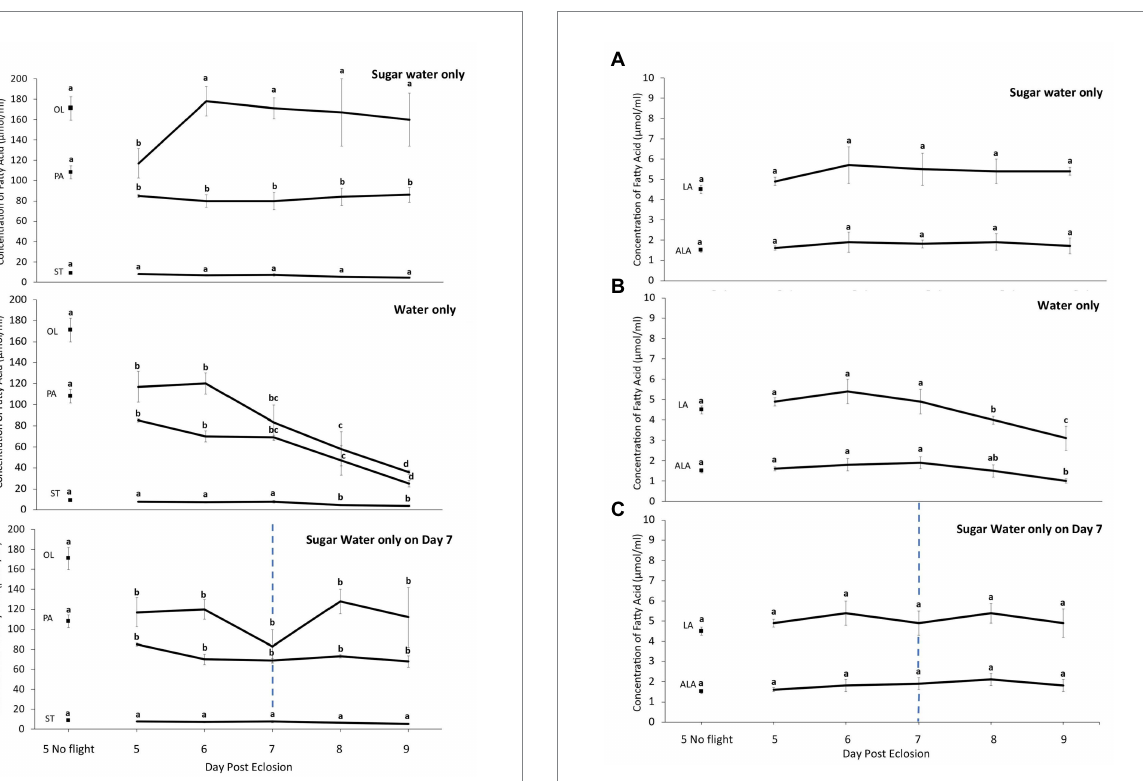
FIGURE 4 Change in the concentration of non-essential [palmitic (PA), oleic (OL) and stearic (ST)] fatty acids in fat body of true armyworm moths reared under fall conditions as a function of the number of 8-h flight periods when fed (A) sugar water ad lib daily, (B) provided water only, or (C) provided water on all days except at the end of Day 7 when they were provided sugar water ad lib during the rest period. The two values for Day 5 represent samples taken from un-flown moths prior to the flight period and from moths after 8 h of flight. In the other days samples were taken at the end of the flight period. Letters indicate statistically significant differences in each category of fatty acid (Tukey’s HSD, p < 0.05). N = 10 per sample group ( N = 20 in Day 5 no flight).